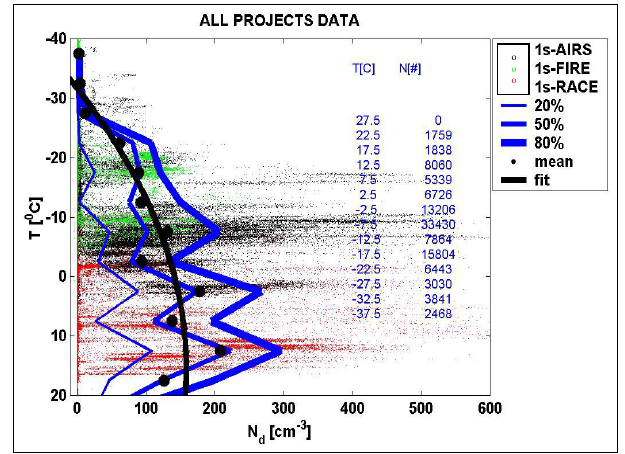
Fig. 5. Scatter plots of FSSP-100 concentrations for the 5–95 µ m interval versus T , for all field projects. Mean, median, and per- centile values (filled circles) are indicated in the legend. The num- ber of points versus T is also shown on the figure. The color points are for 1-s data from AIRS, RACE, and FIRE.ACE. The solid line is for the best fit (Eq. 2) to the mean